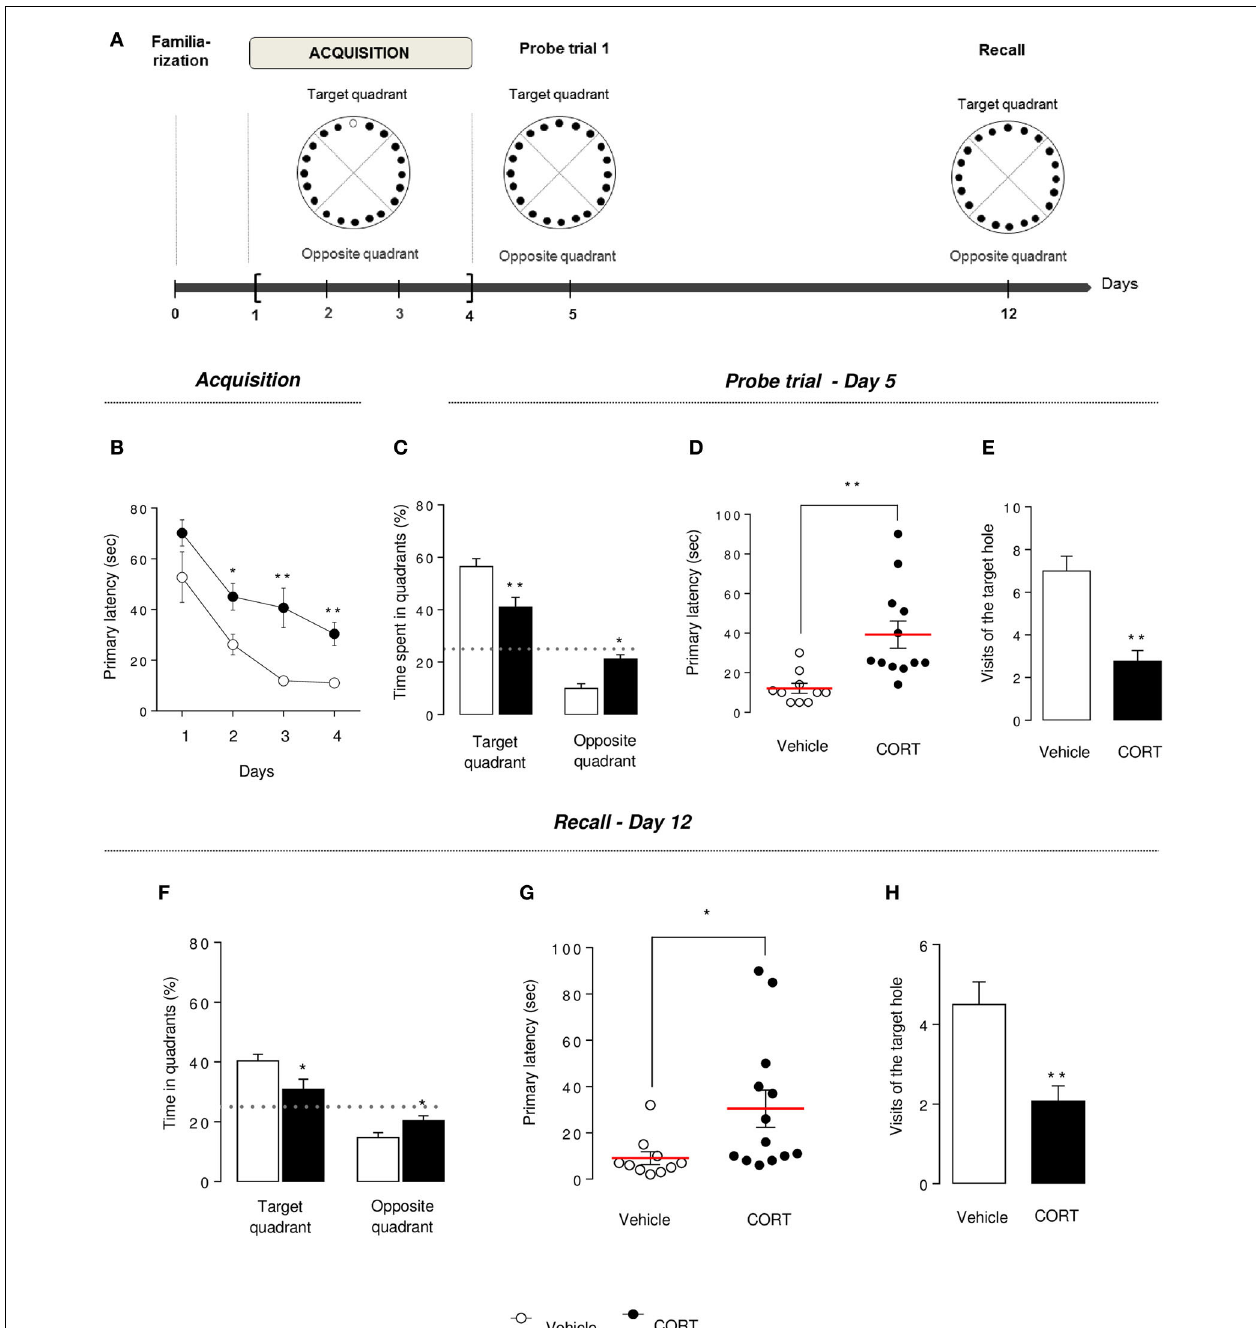
FIGURE 5 | Chronic corticosterone affects spatial learning performances and memory in the Barnes maze. Schematic diagram of the of the BM experimental time course (A) . Animals were trained during 4 days to learn the location of the target box. A first probe trial estimates short-term memory (Day 5). A second probe trial (recall) estimates long-term memory (Day 12). During acquisition (Day 1–4), learning was monitored by recording primary latency during the training sessions (B) . During the first probe trial (Day 5), the target box was removed and the target hole was closed.